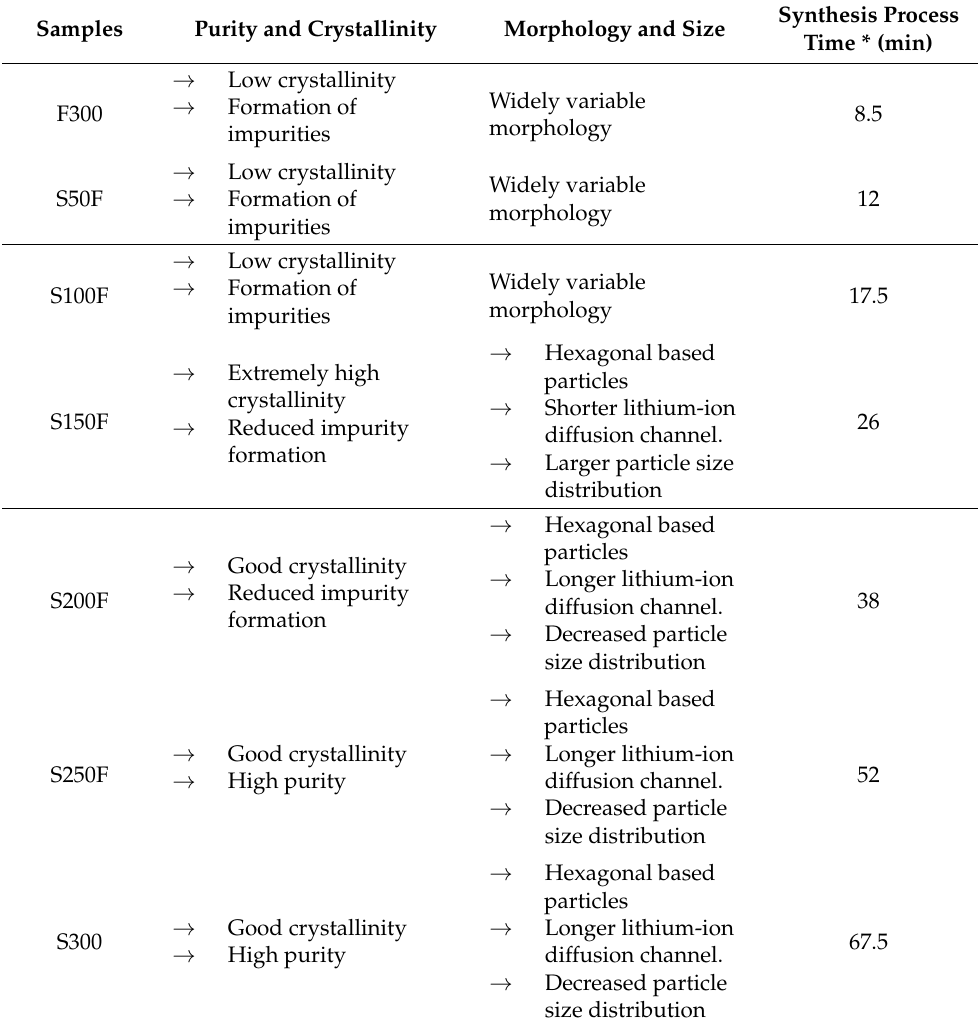
Table 6. Summary of effects from the varying parameters considered in this study on the following particle characteristics: purity, crystallinity, morphology, and